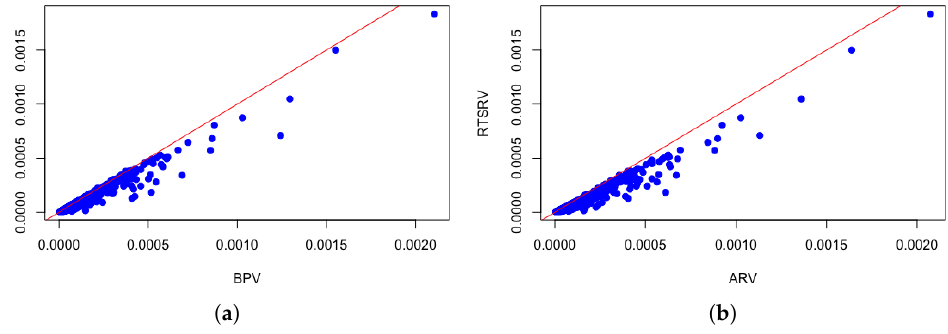
Figure 3. Jump robust two times scaled realized variance against other realized volatility estimators. ( a ) benchmark versus bipower variation; ( b ) benchmark versus average subsampled